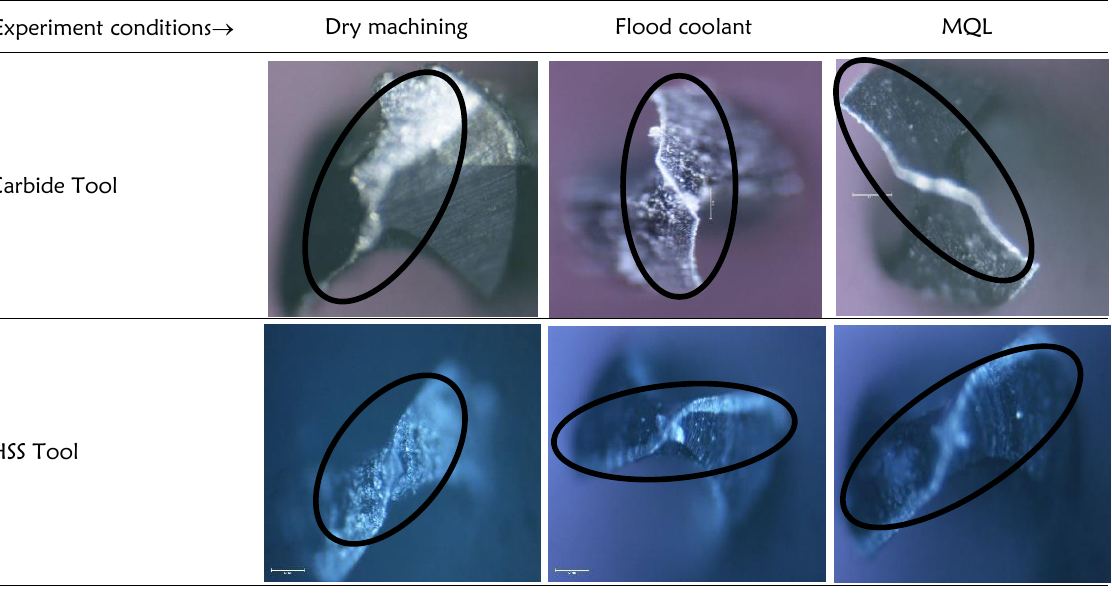
Table 4: Flank wear for Carbide and HSS